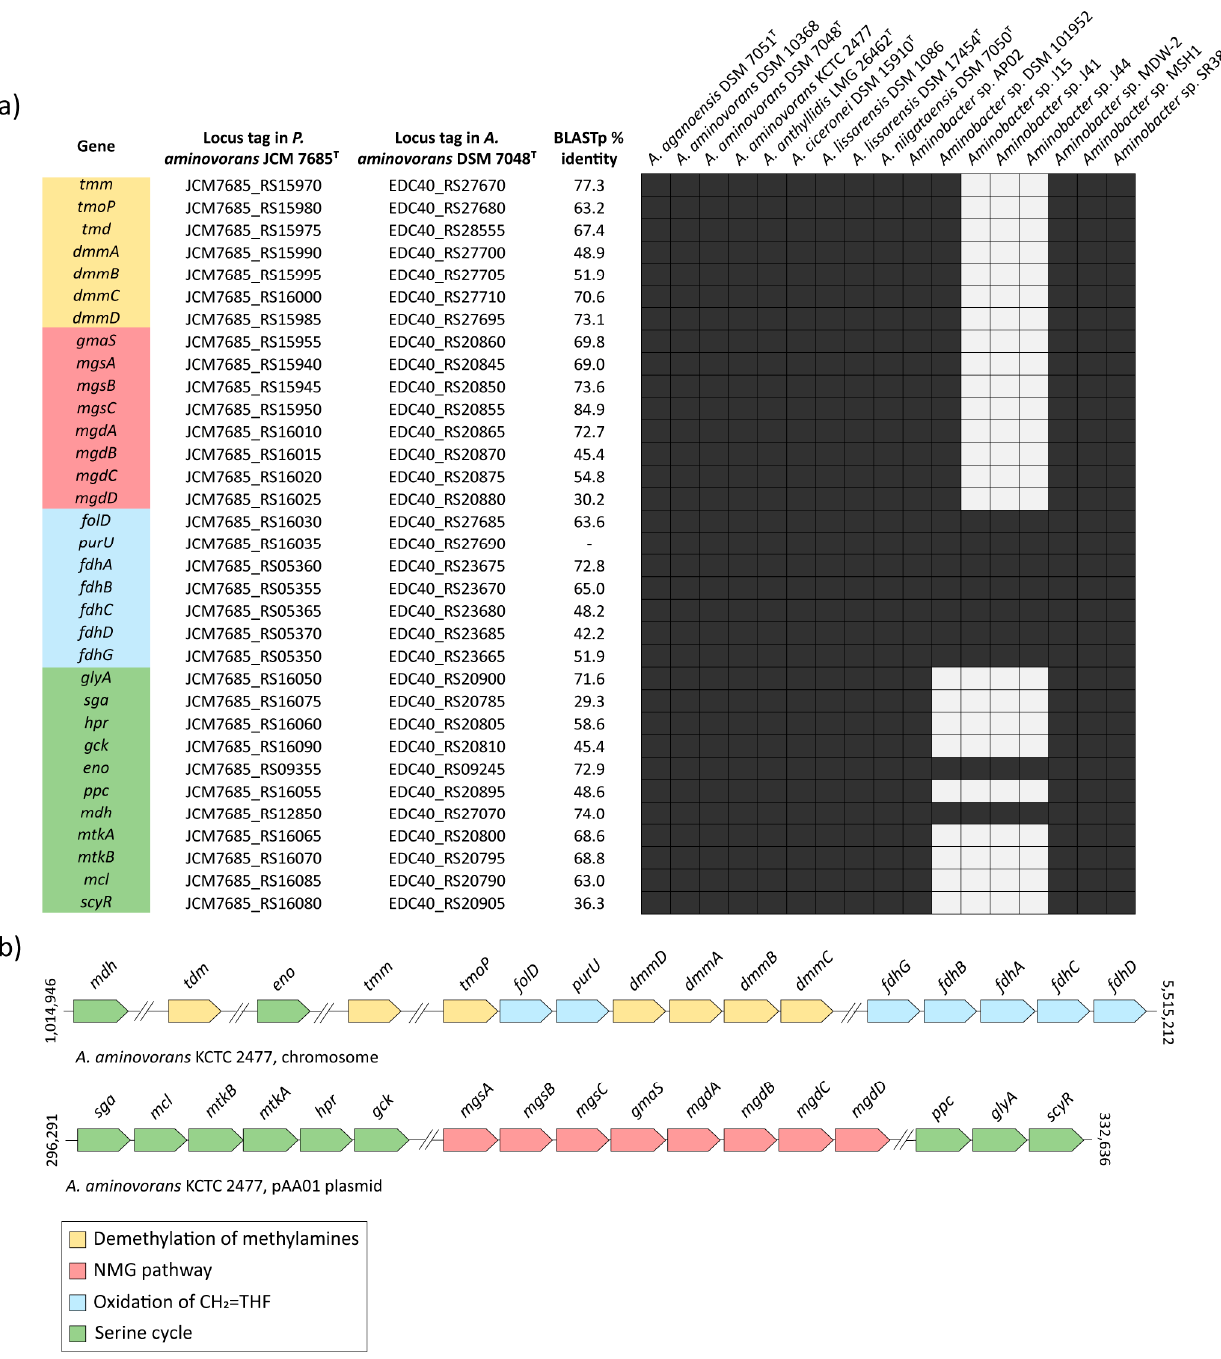
Figure 7. ( a ) Summary results of BLASTp searches of translated nucleotide sequences from the methylotrophy gene clusters from P. aminovorans JCM 7685 T in A. aminovorans DSM 7048 T . Presence/absence of each gene in all Aminobacter genomes is represented by black/white blocks. Putative genes are colored according to the metabolic pathways (see key); ( b ) Methylamine degradation genes organization from A. aminovorans KCTC 2477. Genes are colored according to the metabolic pathways (see key). Double slash marks denote genome regions that are not shown. Coordinates are numbered according to the first base of each contig. The map is not to scale.